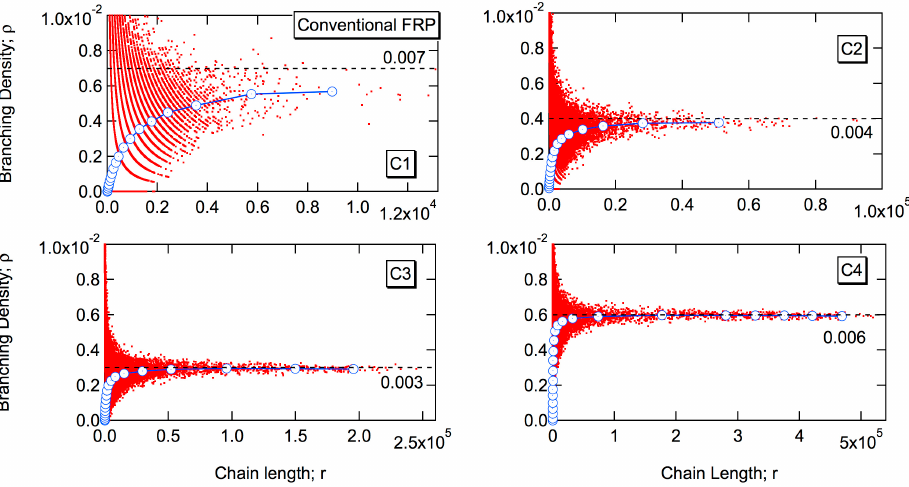
Figure 8. Relationship between branching density and chain length in conventional free-radical emulsion polymerization, for the conditions C1–C4.